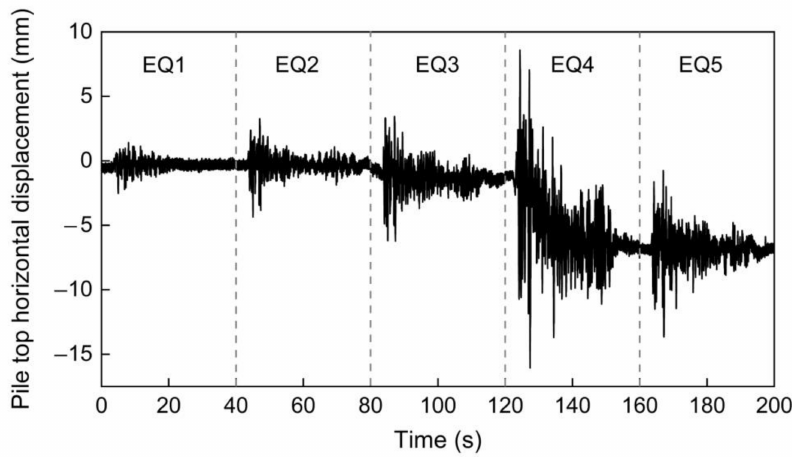
Figure 12. Pile top horizontal displacement under seismic excitations in the 2# model.